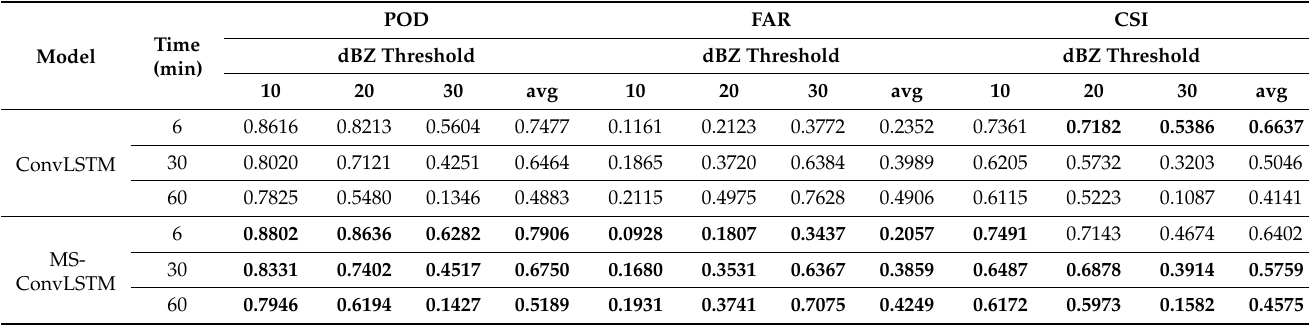
Table 3. The probability of detection (POD) values, false alarm rate (FAR) values, and critical success index (CSI) for test sample 2 at 6 min, 30 min, and 60 min. The best results are marked in bold